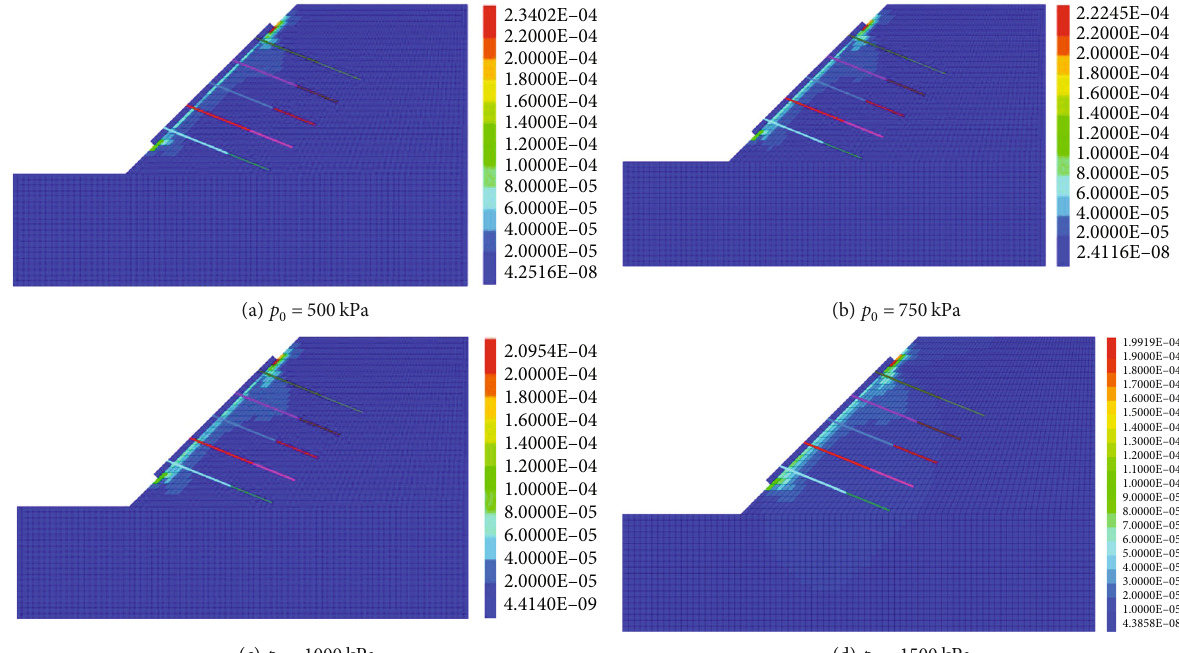
Figure 15: Maximum shear